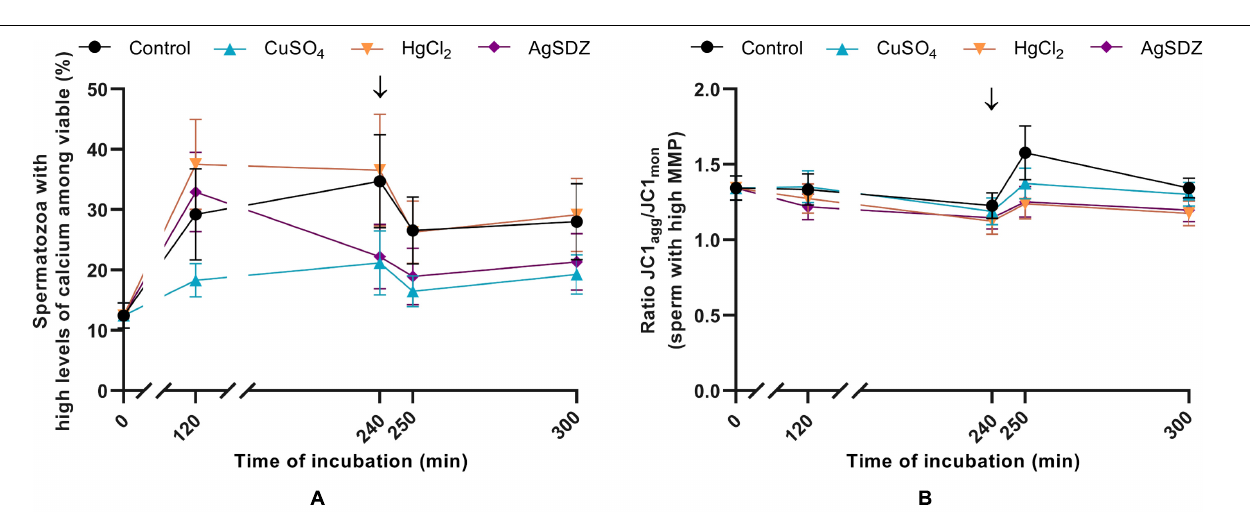
of VSL ( Figure 2B ), VAP, LIN, or WOB ( P > 0.05) at any time point ( Tables 1 , 2